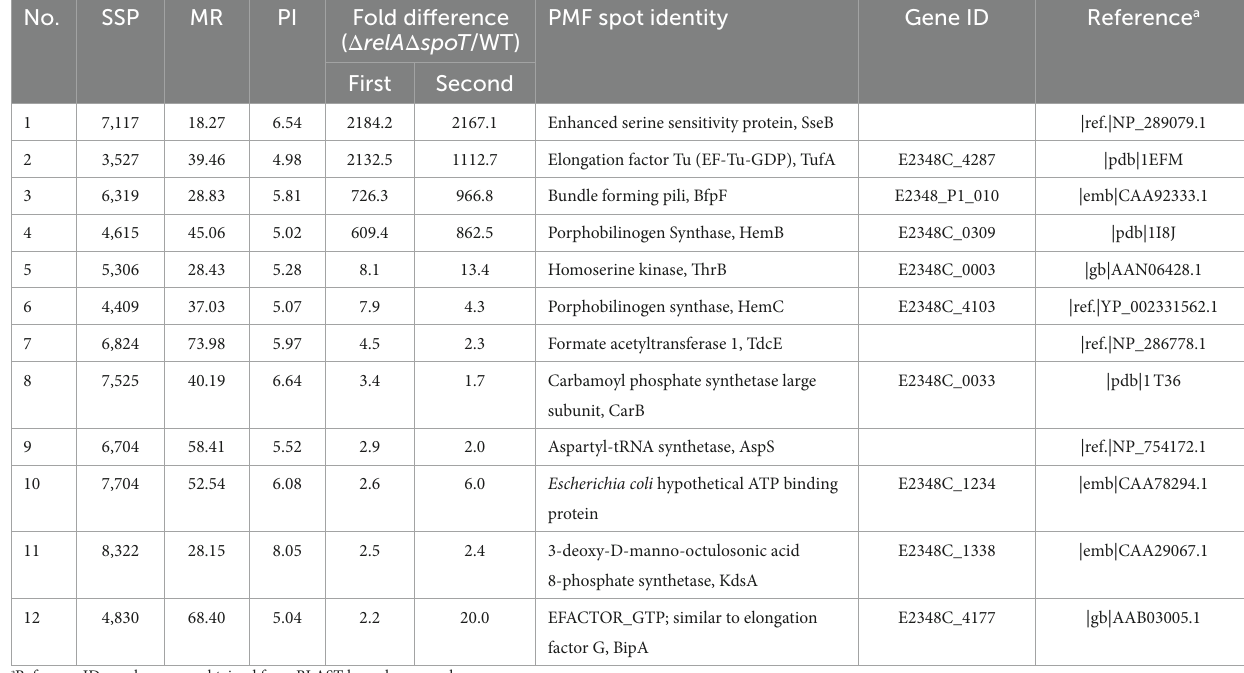
TABLE 1 Identification of EPEC proteins upregulated in the Δ relA Δ spoT EPEC (>1.5-fold). No. SSP MR PI Fold difference PMF spot identity Gene ID Reference a ( Δ relA Δ spoT /WT)